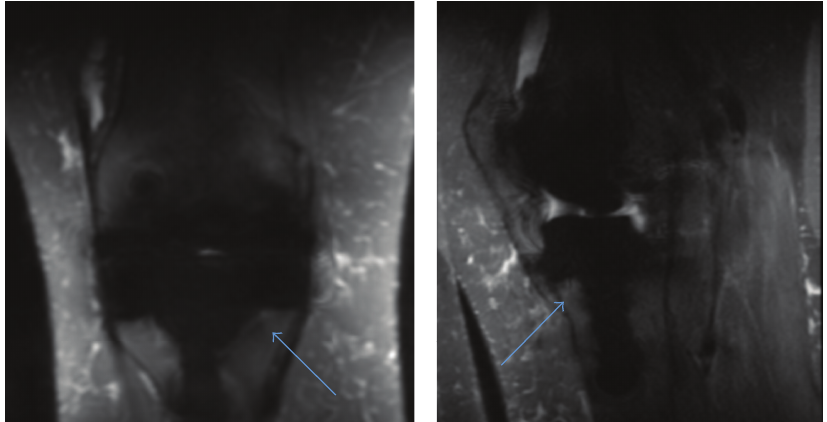
Figure 4: Coronal and Sagittal MAVRIC (cid:2) STIR SLR MRI showing complete resection and resolution of BMLs 12 months after TKR surgery (blue